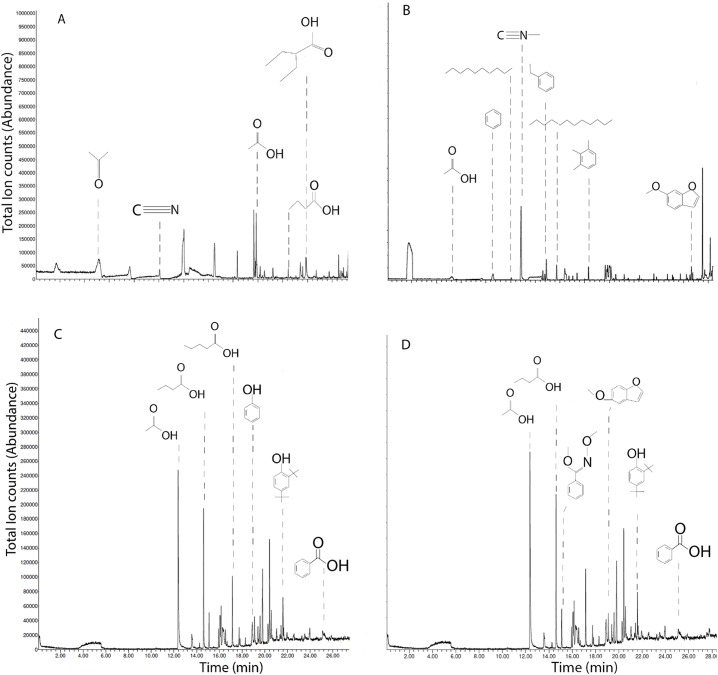
Ion chromatograms of SPME on biochars and leachates.Total ion chromatograms of HS-SPME of maple (A) and spruce (B) biochar, and DI-SPME of maple (C) and spruce (D) water leachates.